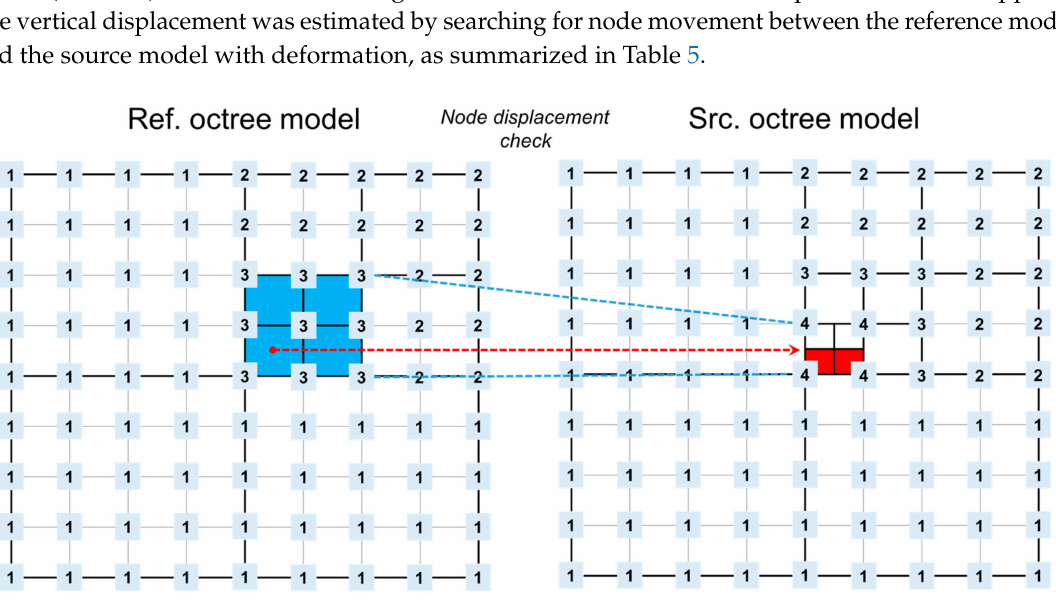
Figure 6. Detecting variant nodes viewed from the perspective above the root node.